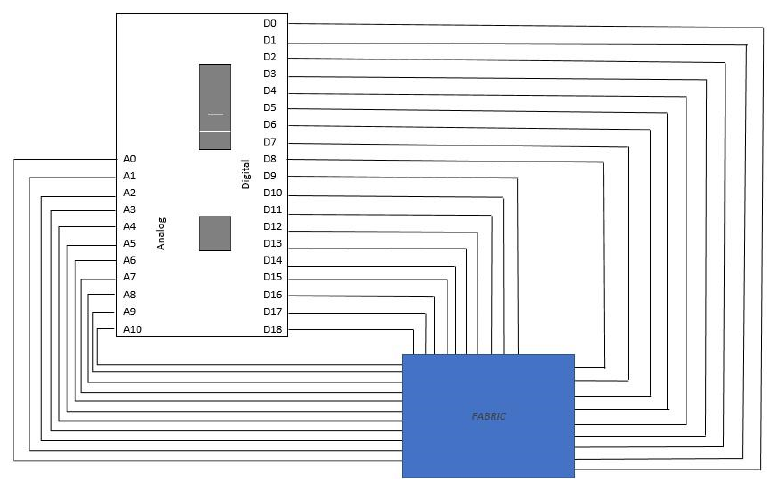
Figure 3. The basic electrical schematic of the connector box.